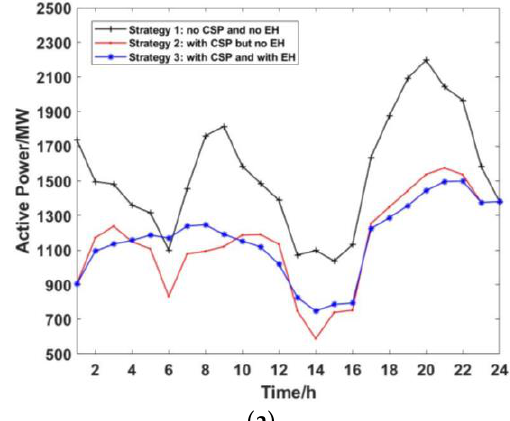
19 of 30 Figure 6. CSP reserve planning results at stochastic scenario 3, including: ( a ) the total scheduled up reserves and reserve deployment in CSP stations; ( b ) the total scheduled down reserves and reserve deployment in CSP stations . Figure 6a,b illustrate the results of the reserve planning in CSP station, including the overall scheduled up/down reserves in CSP stations and the actual reserve deployment in the stochastic scenario 3. Clearly, CSP is verified to provide reserve services owing to the employment of the large-capacity TES system. The optimized reserve solution could effectively reduce the economic cost by diminishing the up/down reserve during the valley load period. However, during the peak load period, more up reserves are provided to decrease the load shedding (e.g., results from 9:00– 11:00 and results from 19:00–21:00). Meanwhile, the up reserve deployment and down reserve deployment could operate within the scheduled reserves. To sum up, the capability of the CSP station to provide reserve services could reduce the requirement of thermal unit reserve, thus promoting the penetration of renewable energy. 5. Discussion In this section, in order to show the advantages of the proposed model, the comparison tests of